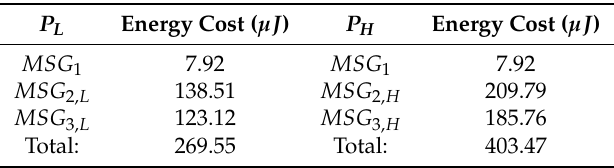
Figure 17. Communication overhead of the proposed scheme compared with those of three existing works [6,8,9]. Table 4. Communication energy cost.